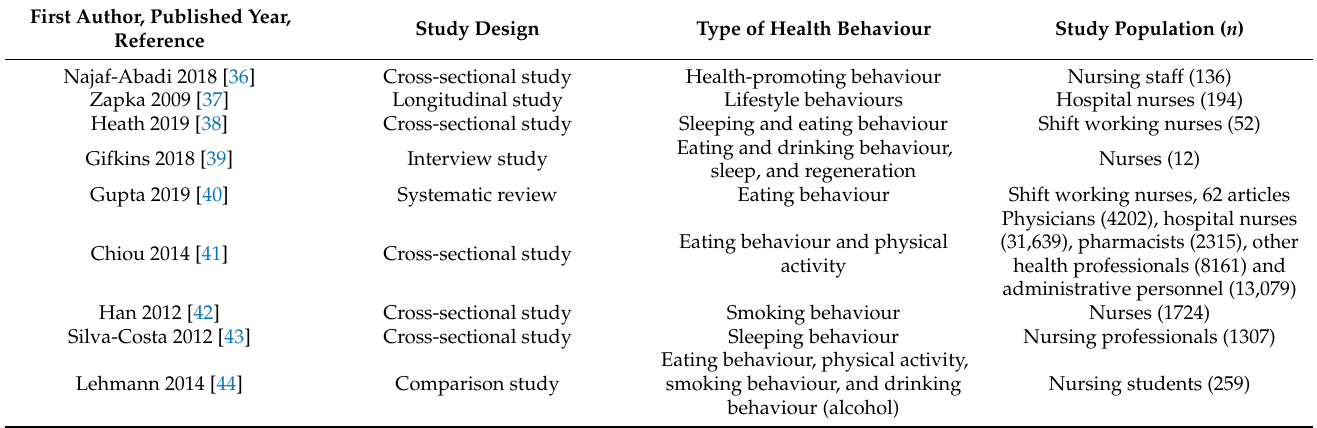
Table 1. Summary of current studies on nurses’ health